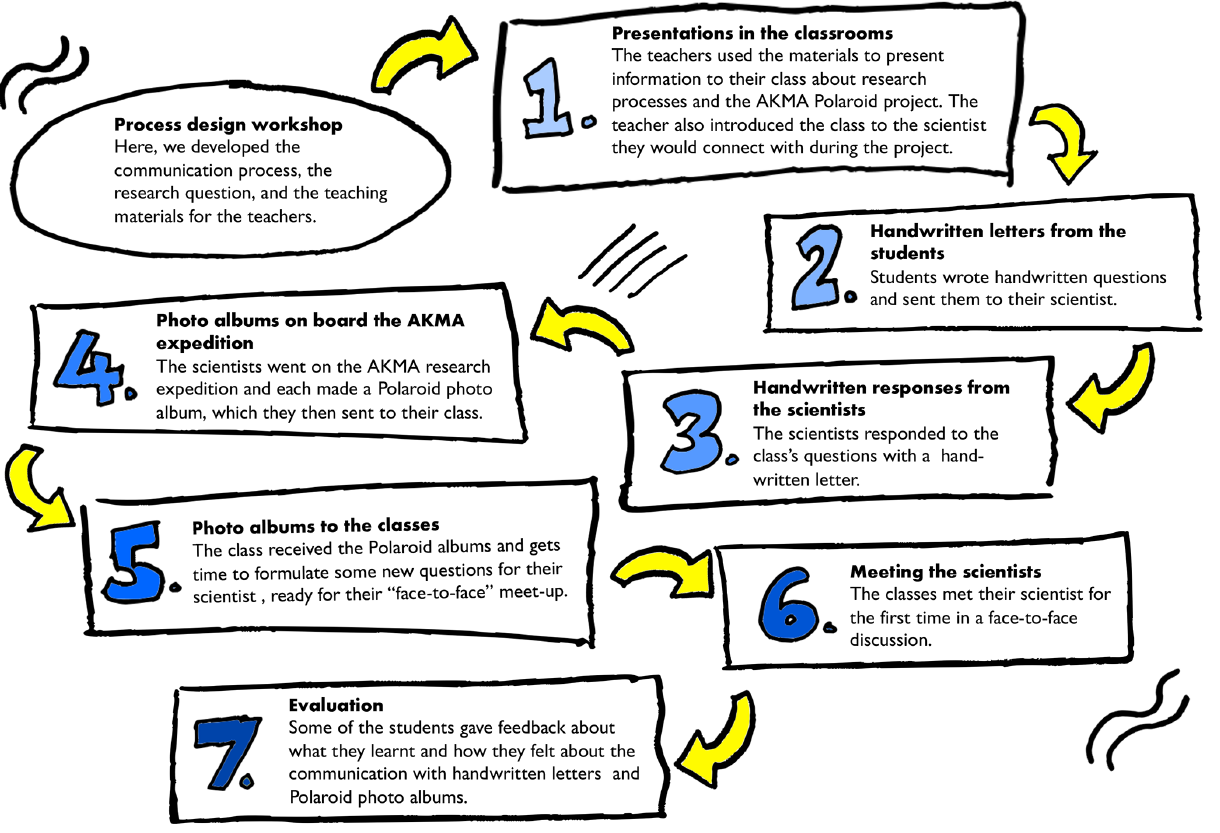
Figure 1. The process we followed during the AKMA Polaroid project, from the initial project development, through the communication activities, and ending with the evaluation questionnaire that the students filled